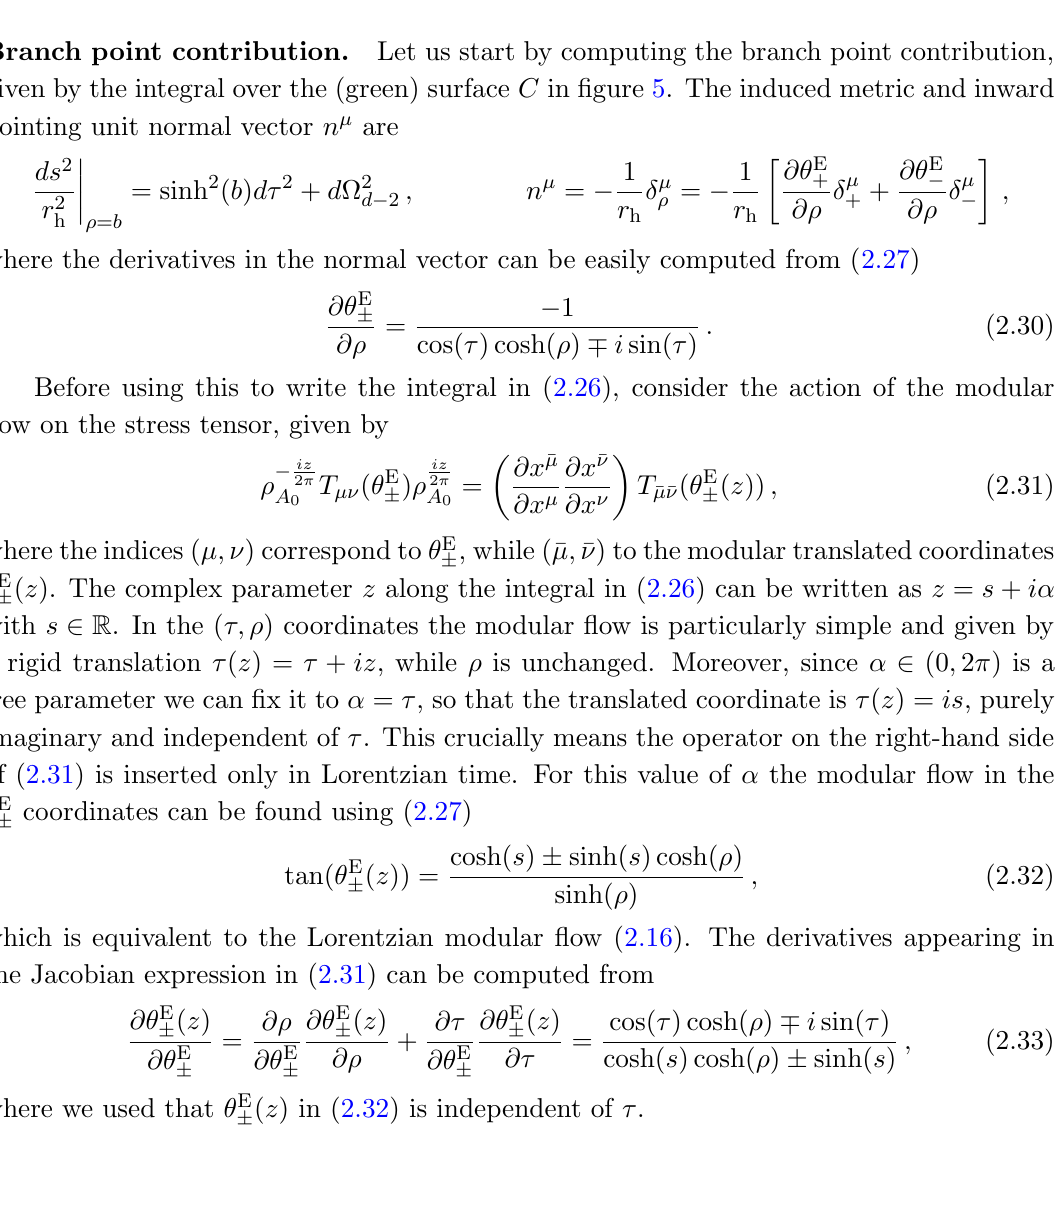
Figure 5 . Sketch of the boundary @ M E obtained from the regions R (cid:6) (in blue) and C (in green) described in (2.29) as (cid:15); b ! 0. The red wiggly line corresponds to the branch cut in the Euclidean space-time located at (cid:27) E = 0 and (cid:18) 2 (0 ; (cid:25)=